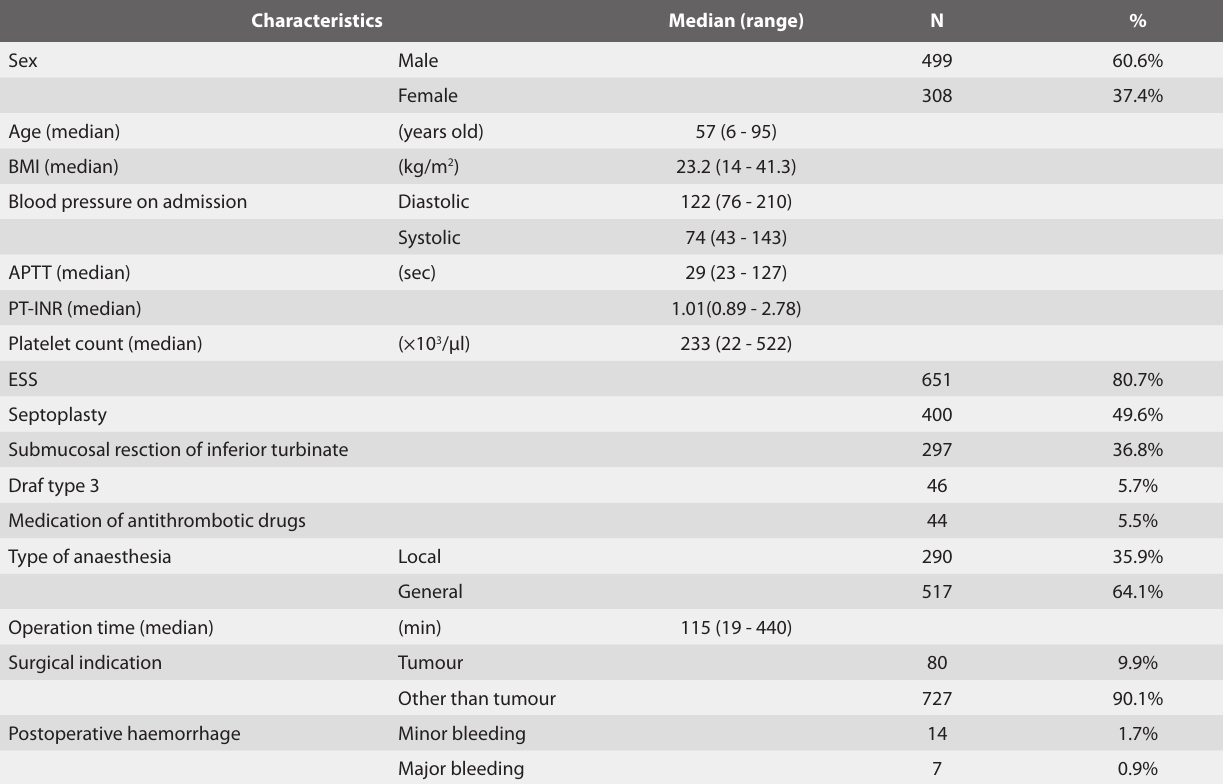
Table 1. Demographics of the cases.